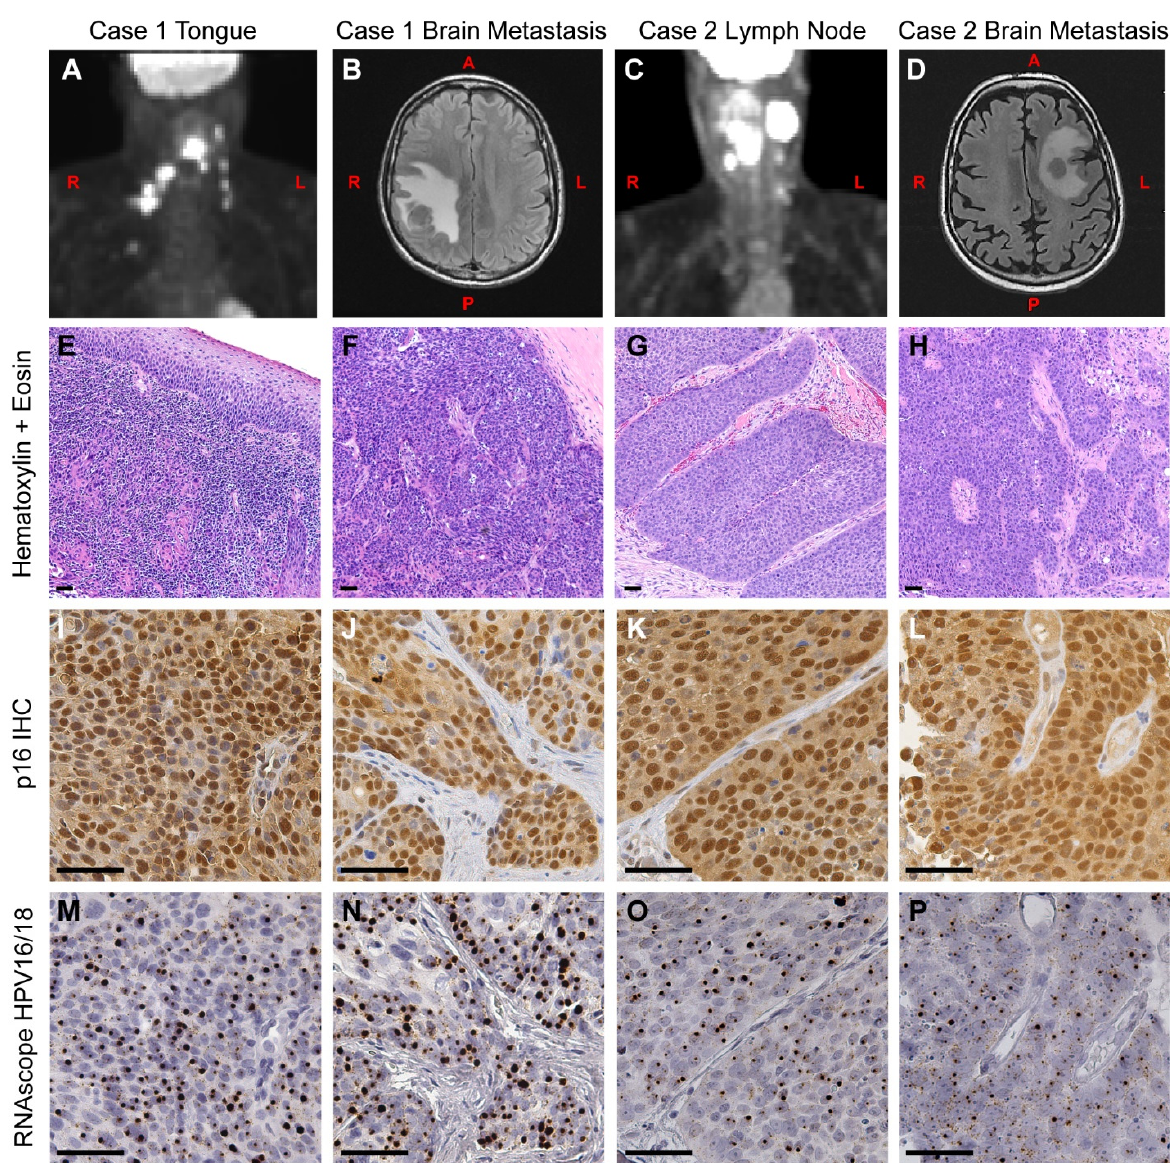
Figure 1. Clinical presentation and histology of primary and metastatic OPSCC. ( A ) A positron-emission tomography (PET) scan of Case 1 at the time of initial diagnosis, showing the primary tumor and spread to local lymph nodes. ( B ) A magnetic resonance imaging (MRI) scan was taken 16 months later, showing a right parietal mass in the brain. ( C ) A PET scan of Case 2 at the time of initial diagnosis, showing the neck mass and local spread to lymph nodes. ( D ) An MRI was taken 33 months later, showing a metastatic tumor in the left centrum. ( E – P ) Serial tissue sections from Case 1 ( E , F , I , J , M , N ) and Case 2 ( G , H , K , L , O , P ) were used for immunohistochemistry (IHC) and in situ hybridization analysis. ( E – H ) Primary and metastatic brain tumors were stained with hematoxylin and eosin. ( I – L ) Adjacent sections were assayed for p16 INK4a protein expression by IHC. All tumors displayed high levels of nuclear and cytoplasmic staining of p16 INK4a , a hallmark of HPV+ tumors. ( M – P ) Tumors were assayed for HPV16 and HPV18 RNA using the RNAscope HPV16/18 probe set. The presence of HPV RNA is evident in both initial ( M , O ) and metastatic brain tumors ( N , P ). This pattern directly matches the pattern of p16 INK4a overexpression from the adjacent slides. L = left side, R = right side, A = anterior, P = posterior. Scale bar = 50 μ m.